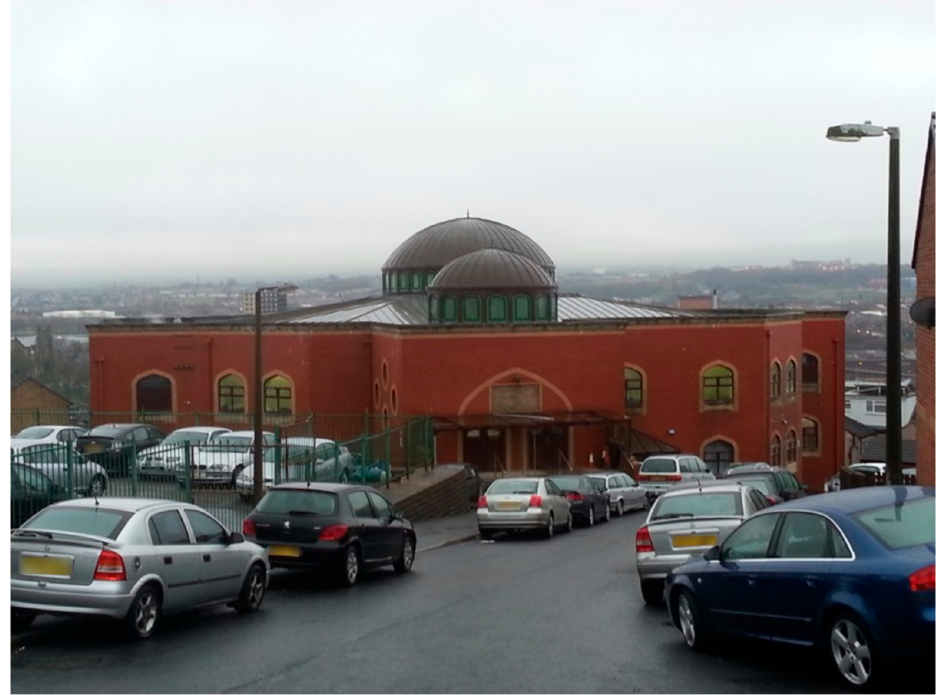
Figure 9. Blackburn Markaz (the number of cars indicating the amount of attendees the weekly programme attracts) Source: author’s photo.